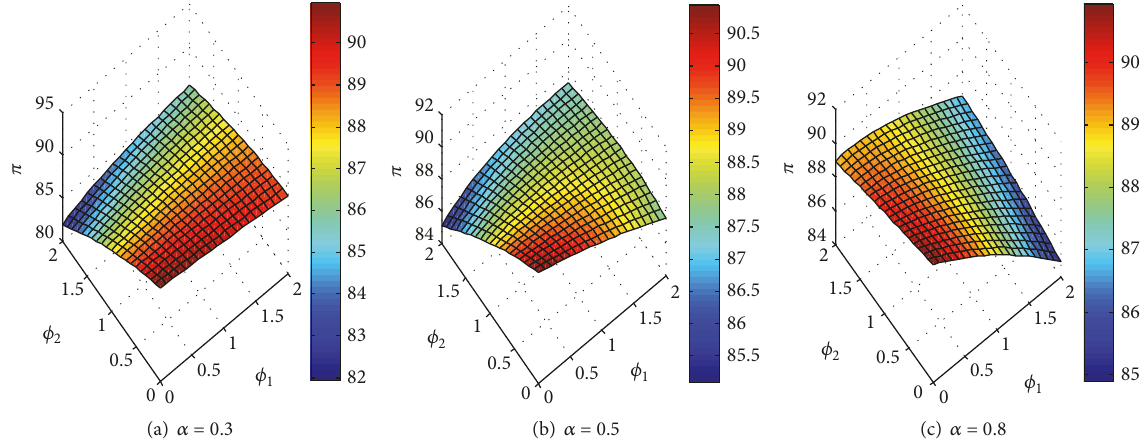
Figure 8: The impact of fairness concern on the total expected profit 𝜋 .